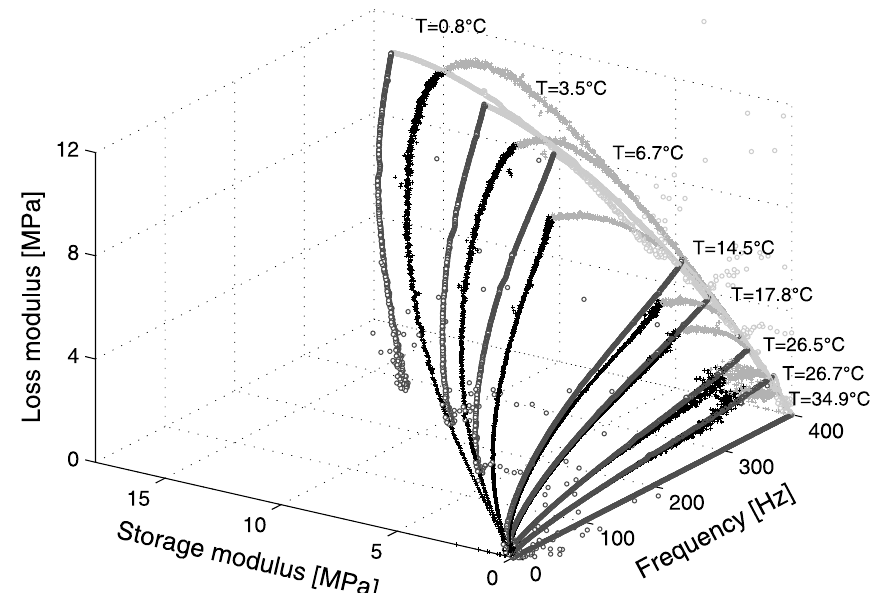
Fig. 3. Representation of the complex modulus data from accelerance (dark grey circle), from receptance (black plus sign) and corresponding projected Wicket plot (light grey).